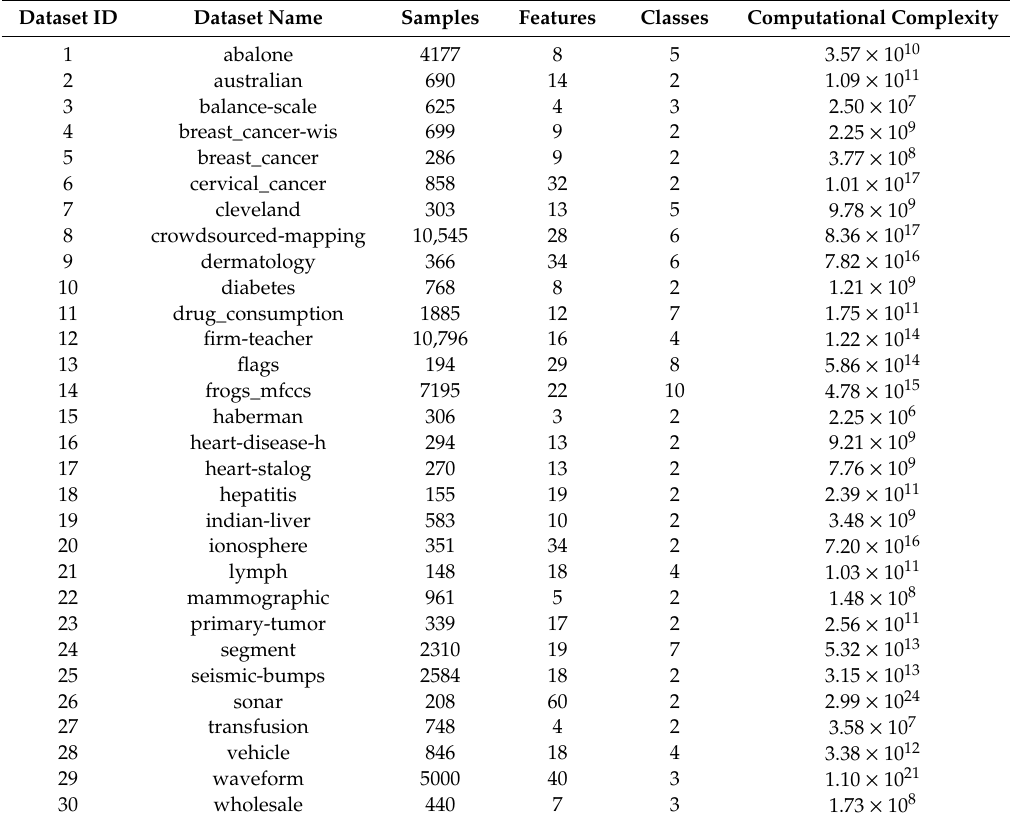
Table 2. Information on the UCI datasets used in the